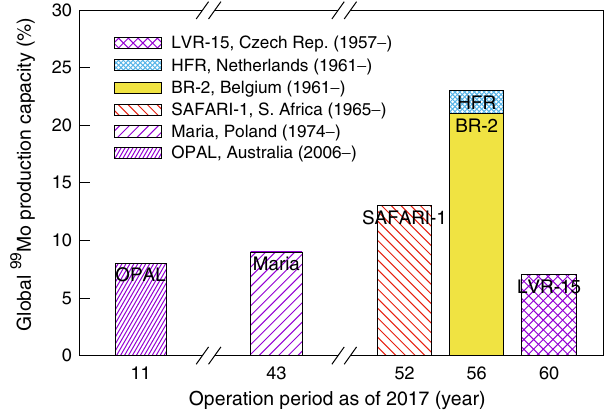
FIG. 1. Operation periods and global 99 Mo production capacities of large-scale research